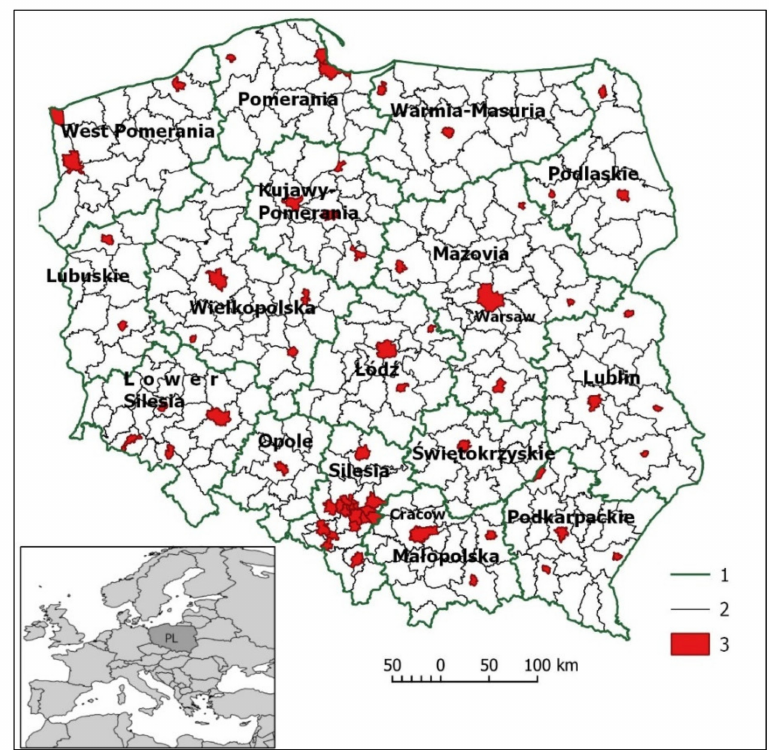
Figure 2. Study area. 1—province border, 2—county border, 3—city counties.